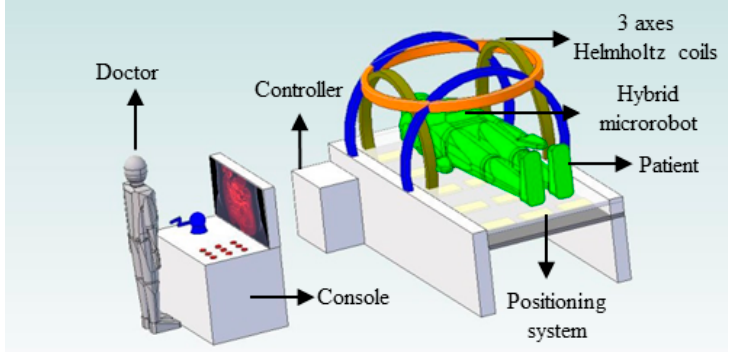
Figure 1. Overall of the control system.